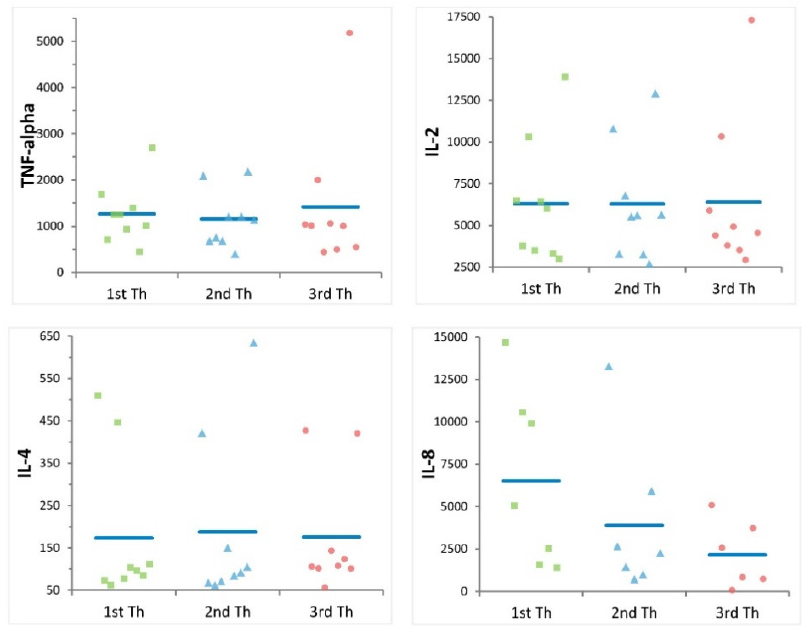
Figure 6. Effect of multiple freezing cycles on cytokine production. Each plot shows the cytokine production (expressed as difference between their concentration after stimulation and at basal level, see Section 4 in nine samples after one (green), two (blue) and three (red) thawing steps (Th). Blue bars indicate mean